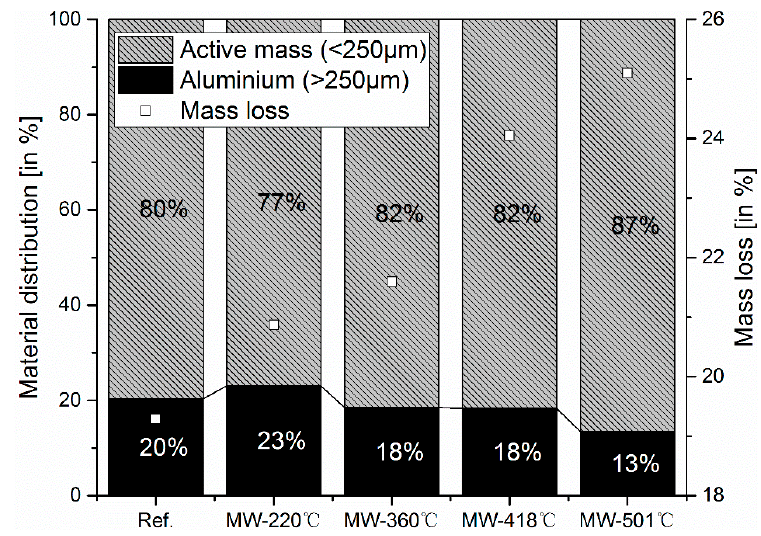
Figure 4. Mass loss and material distribution (active mass vs. aluminum) after pyrolysis.